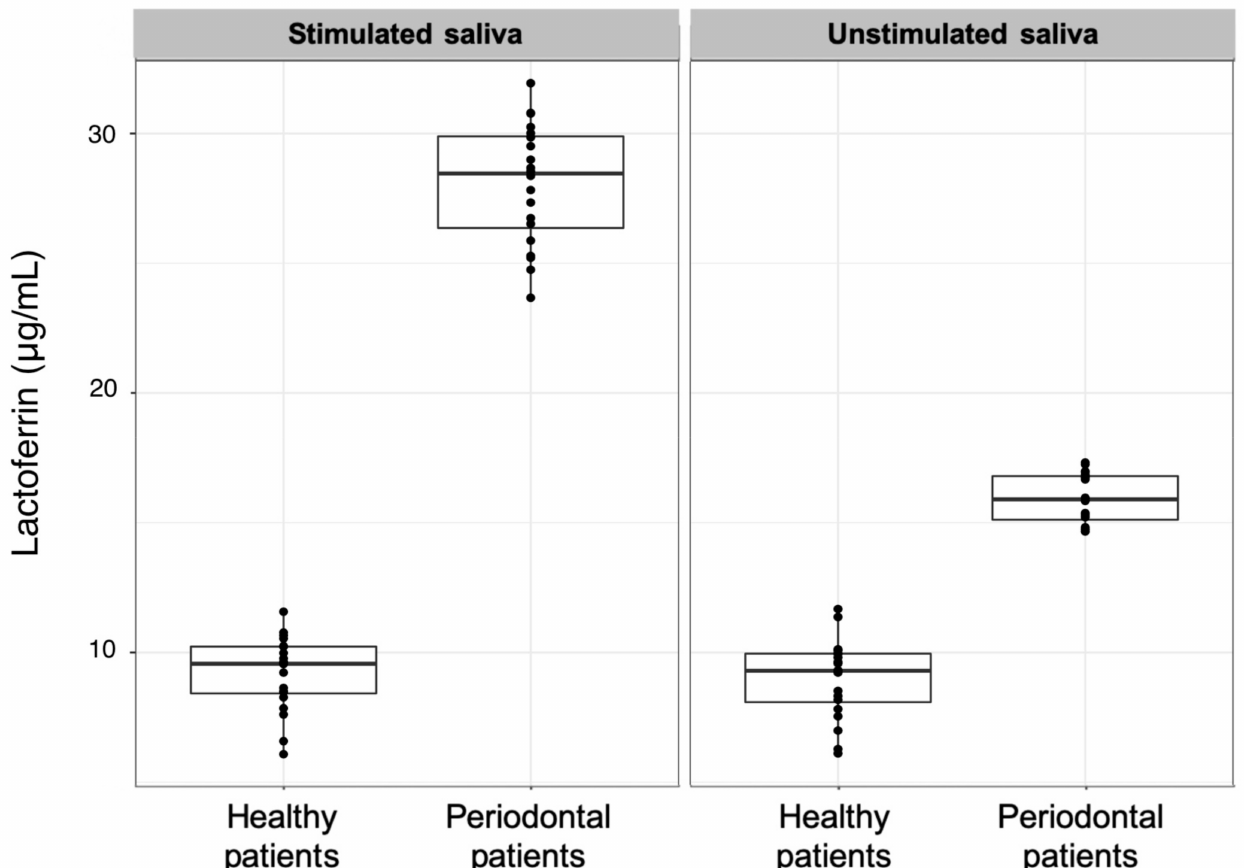
Figure 2. Comparison between lactoferrin measurements in stimulated and unstimulated saliva samples from healthy and stage III grade B generalized periodontal